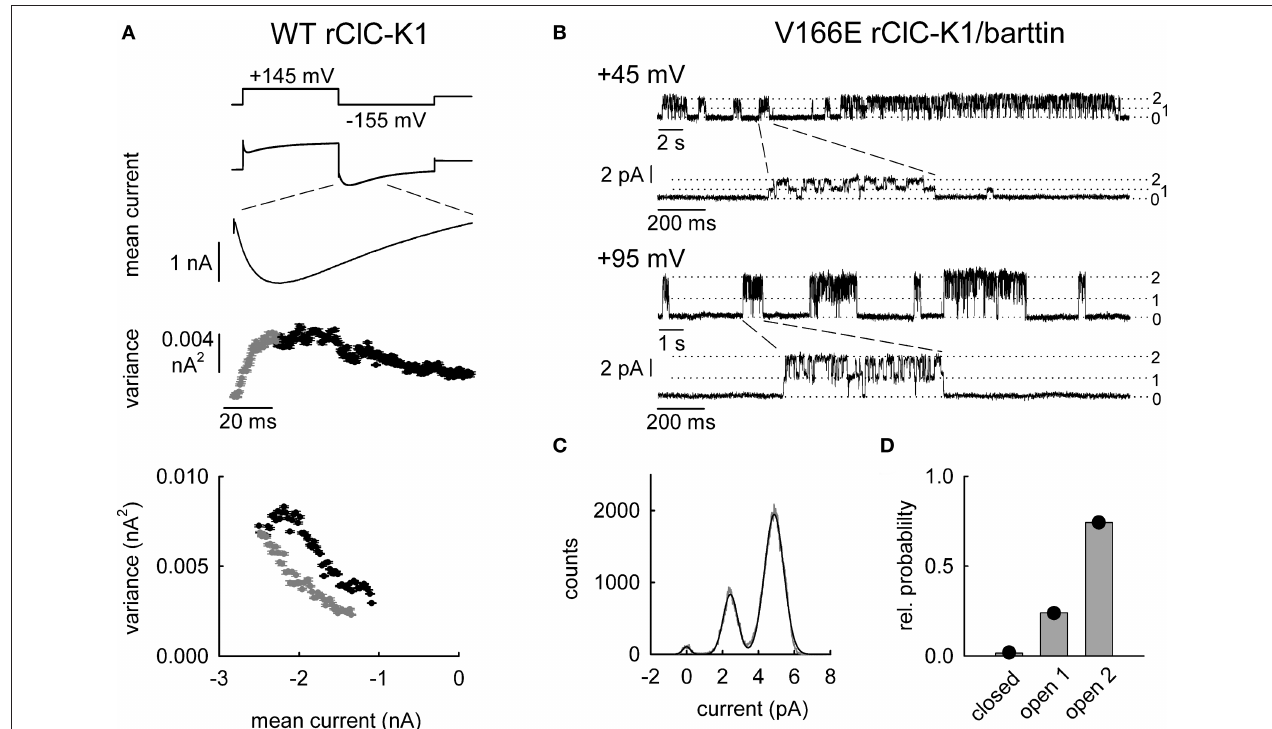
Figure 3 | Analysis of the functional stoichiometry of rClC-K1 channels by non-stationary noise analysis (A) and single channel recordings (B–D). (A) Non-stationary noise analysis of WT rClC-K1 currents in the absence of barttin obtained from whole-cell patch clamp recordings of heterologously expressed channels in mammalian tsA201 cells. Mean currents (upper traces) and variances (middle trace) upon a voltage step that elicits biphasic responses result in a loop-like dependence when displayed in a plot of variances versus mean current amplitudes (lower panel). (B–D) Inside–out patch clamp